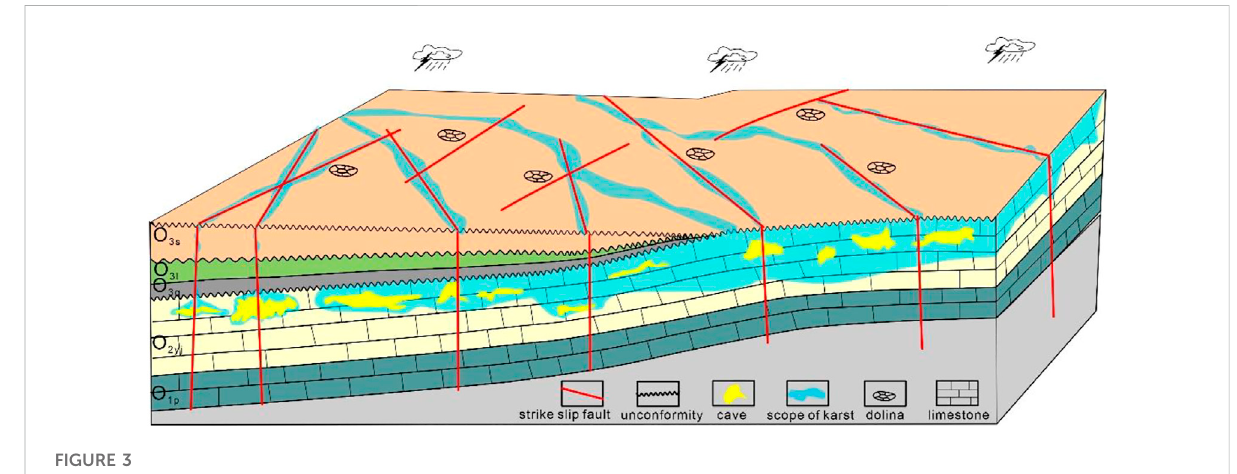
FIGURE 3 Model of reservoir reformation by the downstream fl